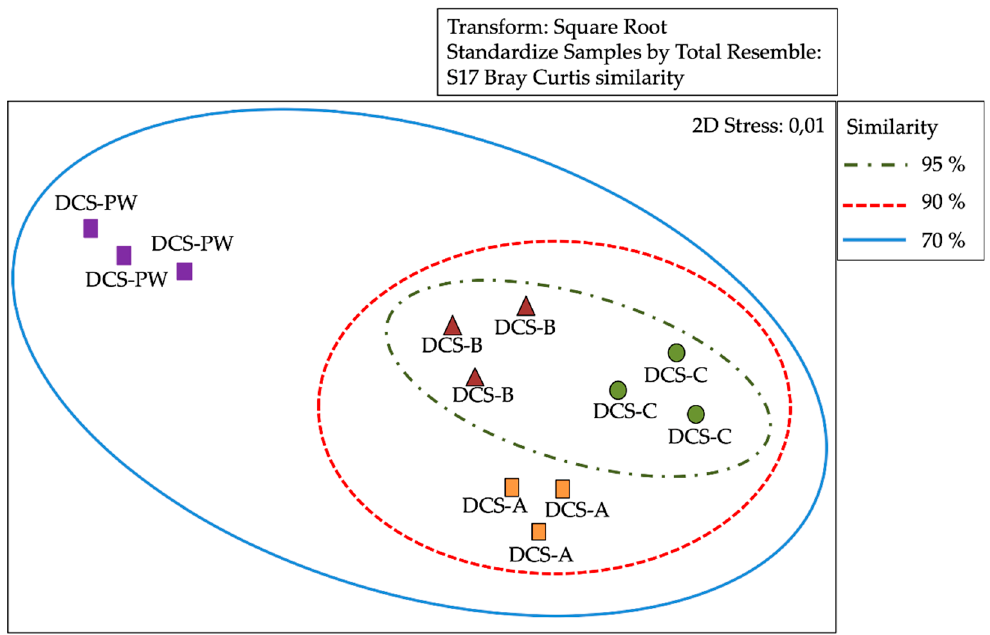
Figure 4. Multidimensional scaling (MDS) of the Denaturing Gradient Gel Electrophoresis (DGGE) data matrix of bacteria 16s rRNA from reverse osmosis (RO) membrane segments and potable water of south-central area dialysis centre (DCS). Similarly, index was evaluated for percentage. DCS-A: initial segment of DCS RO membrane. DCS-B: middle segment DCS RO membrane. DCS-C: final segment of DCS RO membrane. DCS-PW: DCS potable water.